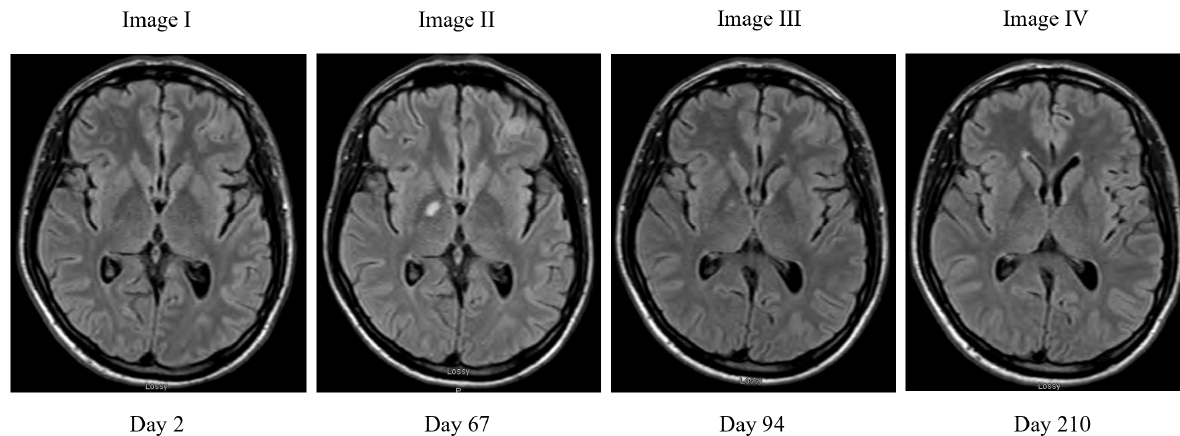
Figure 2. MRI FLAIR changes over time. Image I on admission shows no masses, Image II shows 11 mm enhancing masse in right corpus callosum and left frontal meningioma, Image III shows improvement in the right corpus callosum mass to 4 mm, Image IV shows complete resolution of the mass.